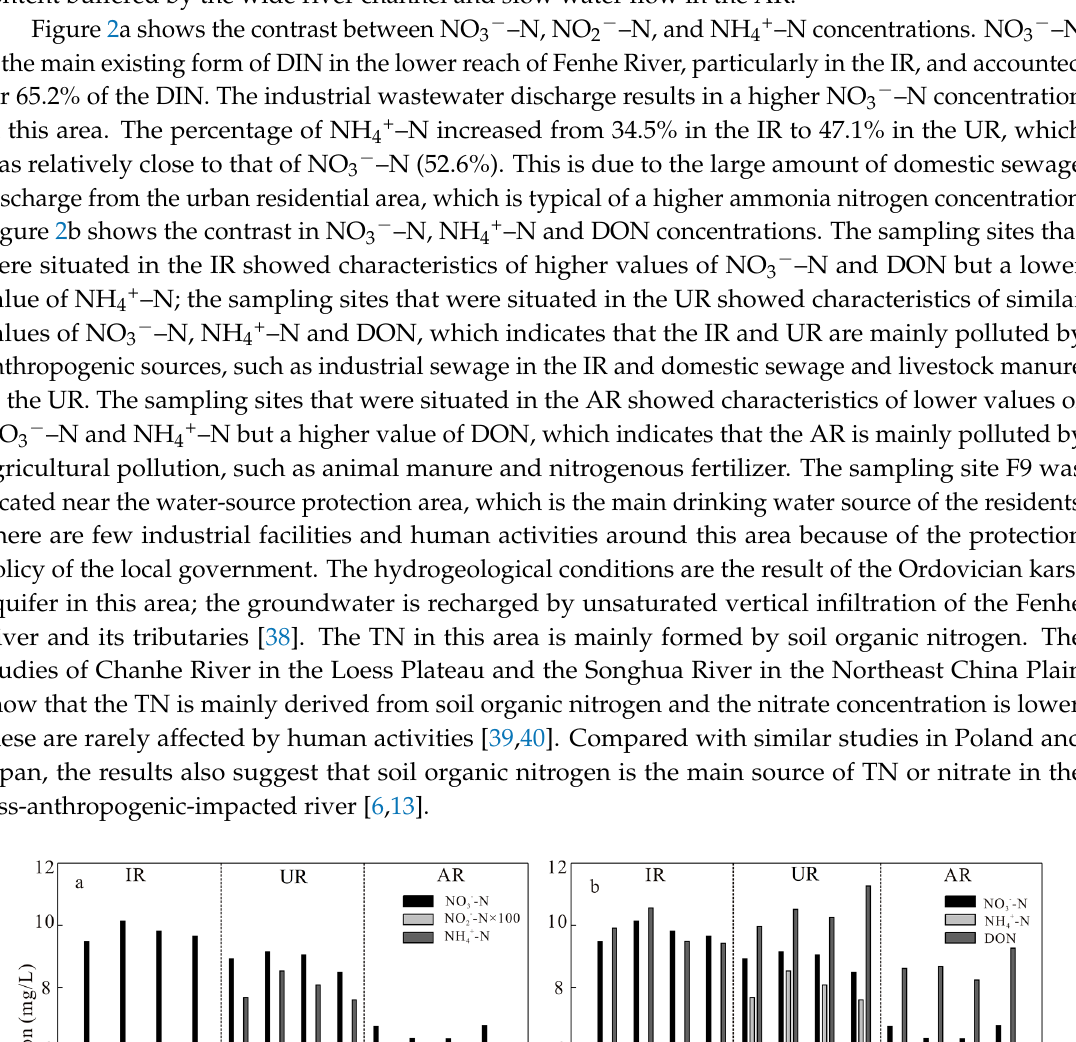
− –N, NH 4+ –N, and dissolved organic nitrogen 3